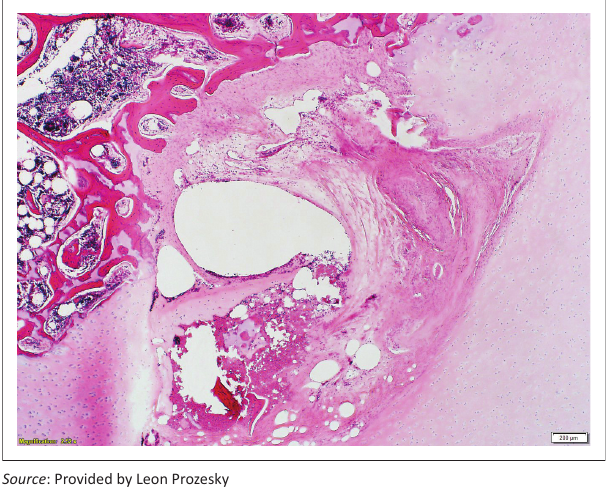
FIGURE 7: Extensive necrosis of the articular–epiphyseal cartilage complex extending to the subchondral bone.